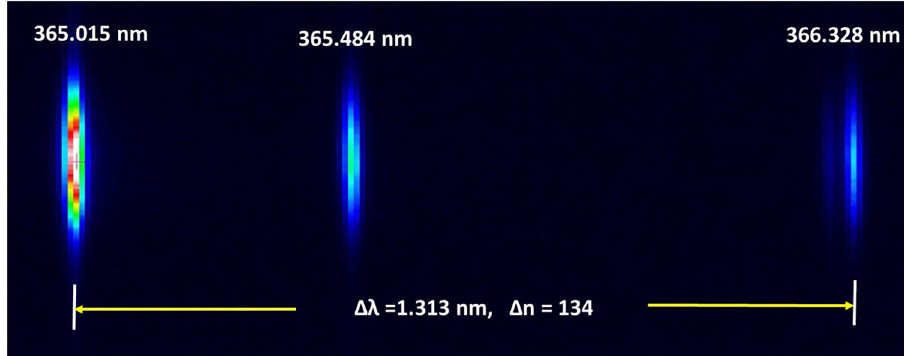
Figure 2. The image of the triple spectral lines of the Hg atom, obtained with ultrahigh resolution by CCD camera with elimination of the coma aberration in the zero-off-axis C–T configuration. These line structures occurred at 365.015 nm, 365.484 nm and 366.328 nm wavelengths, respectively, arise from excited emissions of the Hg atom and are intrinsically related to the electron transitions from the 6 d 3 D 3 , 6 d 3 D 2 and 6 d 1 D 2 states to the